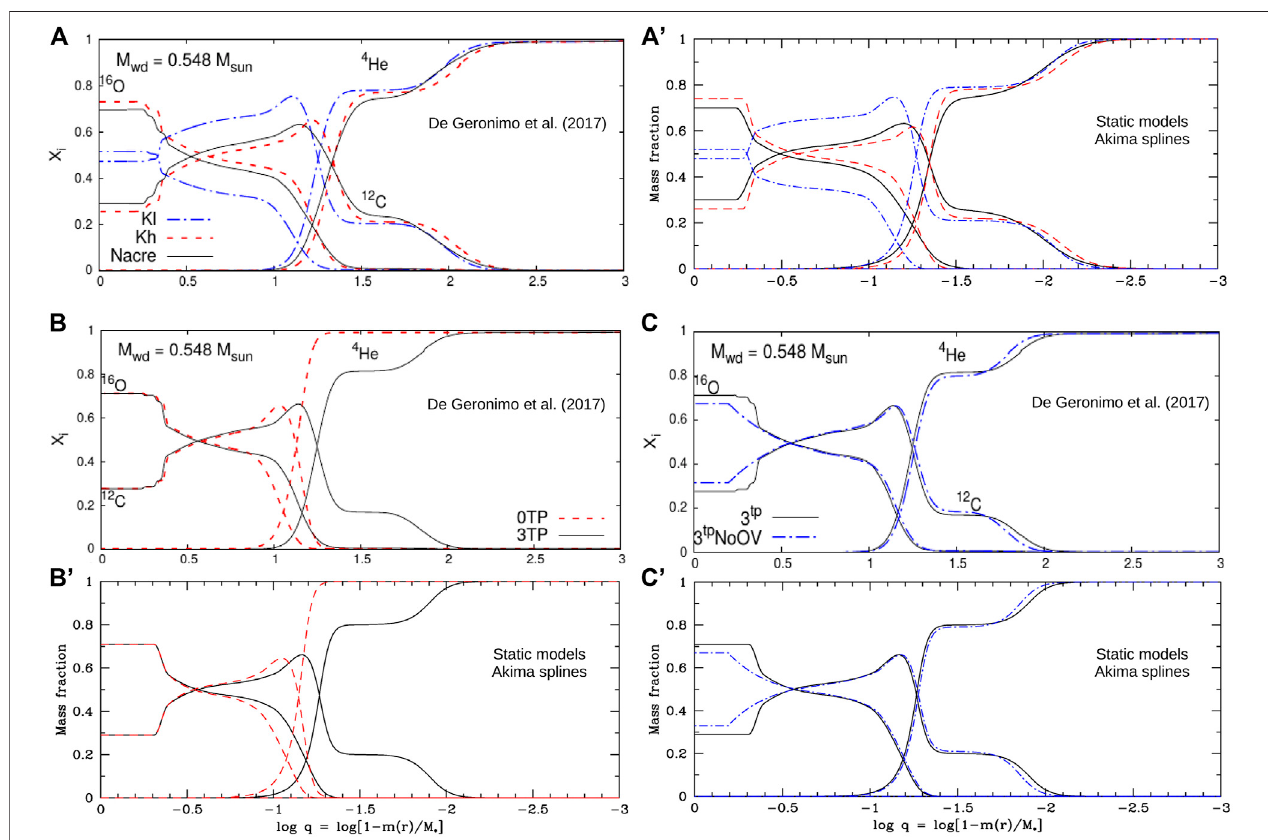
FIGURE 2 | Panel (A) and (A 9 ) : Composition pro fi les of helium, carbon, and oxygen as functions of the fractional mass depth in a typical DA white dwarf produced by assuming different nuclear reaction rates in evolution calculations. Panel (A) is from De Gerónimo et al. (2017), while panel (A 9 ) is a reproduction of these pro fi les with our parametrized static models. Panel (B) and (B 9 ) : Same as above, but for models when no thermal pulse or 3 thermal pulses occur during the post-AGB phase. Panel (C) and (C 9 ) : Same as above but for models with and without convective overshoot in evolution calculations.